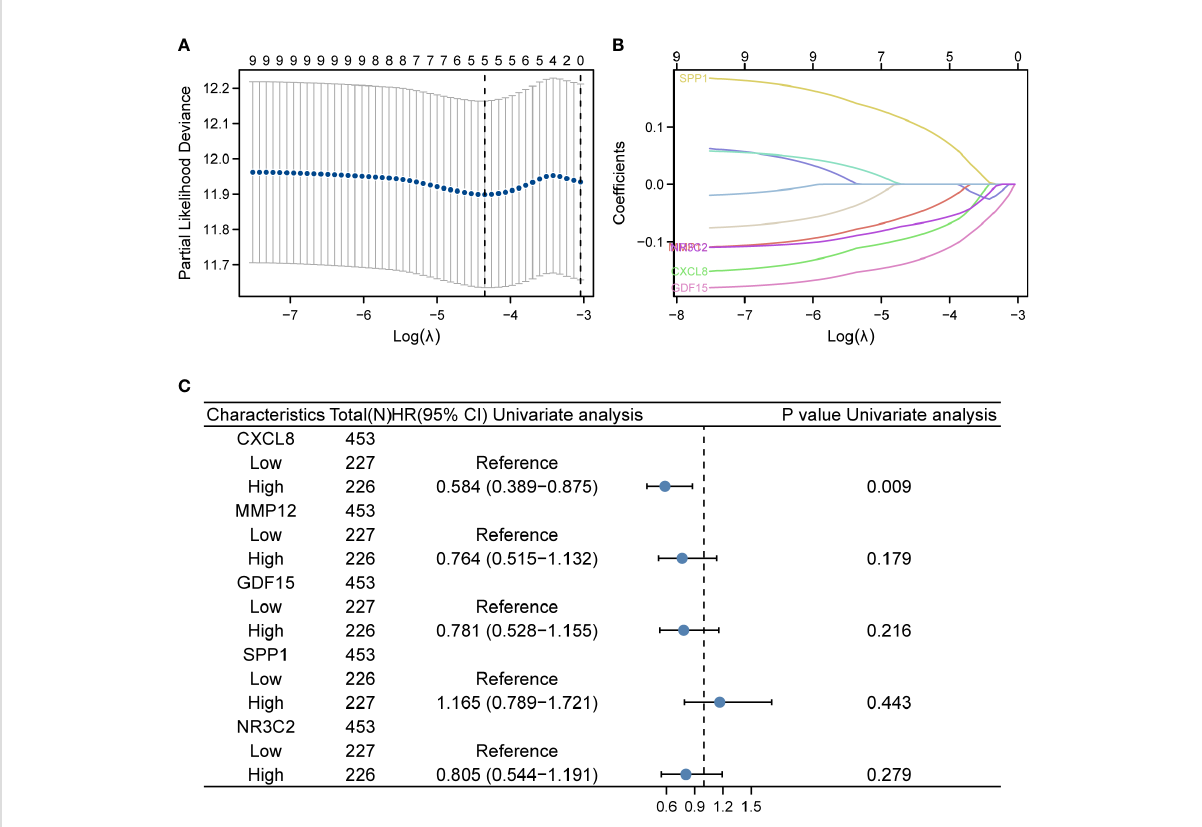
FIGURE 2 LASSO regression and risk score calculation. (A) Coef fi cient value of DEIRGs. (B) Partial likelihood deviance of DEIRGs. (C) Forest plot demonstrating the multivariable Cox model results of each gene in